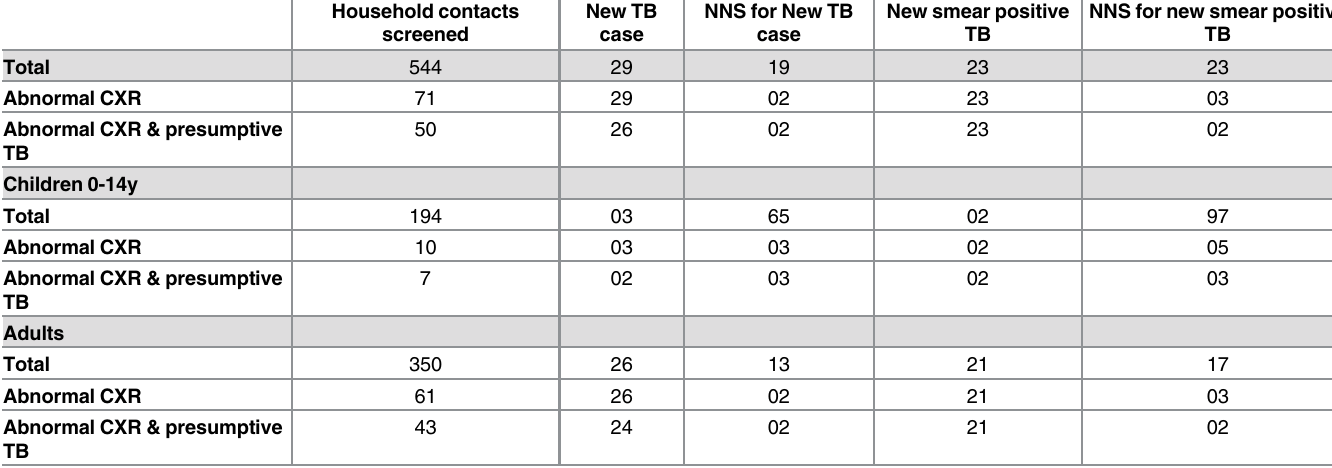
Table 5. Number of household contacts of TB index cases needed to screen (NNS) to identify one new case of TB/smear positive TB, Chennai,